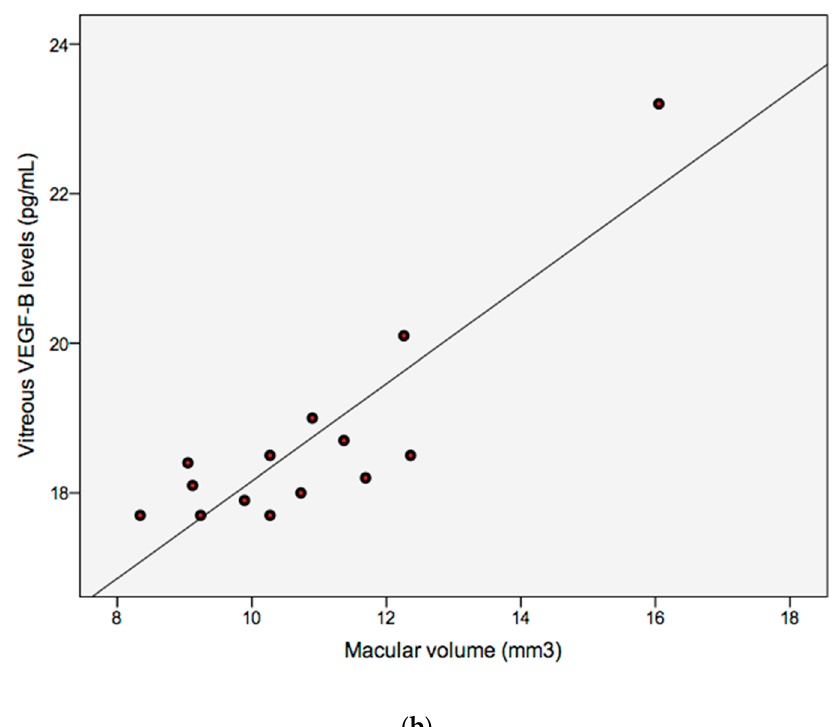
Figure 5. Correlation between vitreous VEGF-B (pg/mL) levels in DR patients ( a ) and central retinal thickness (CRT; μ m), r s = 0.441 ( p ≤ 0.05); or ( b ) and macular volume (MV; mm 3 ), r s = 0.716 ( p ≤ 0.01), analyzed using Spearman’s correlation coefficient.